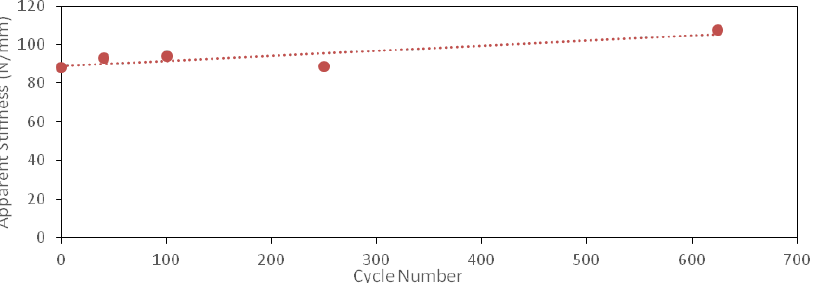
Figure 14. Max. deflection vs. number of cycles at 100 °C and 180 °C (Cp = 2, 0% and 100% humidity).